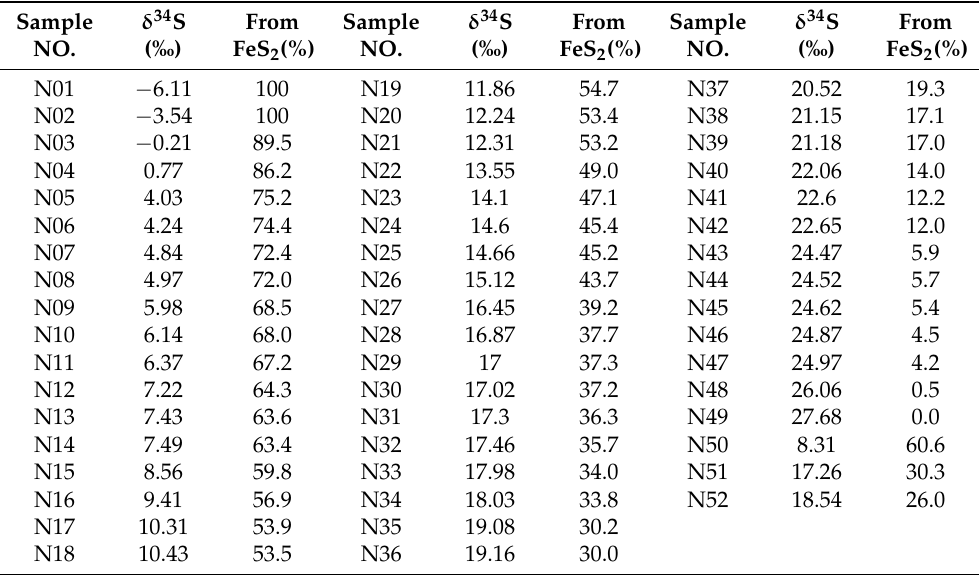
Figure 16. Box chart of δ 34 S values of SO 42 − forming the dissolution of gypsum and forming the oxidation of FeS 2. Table 3. Ratio of sulfate ion from pyrite oxidation in the calculation of